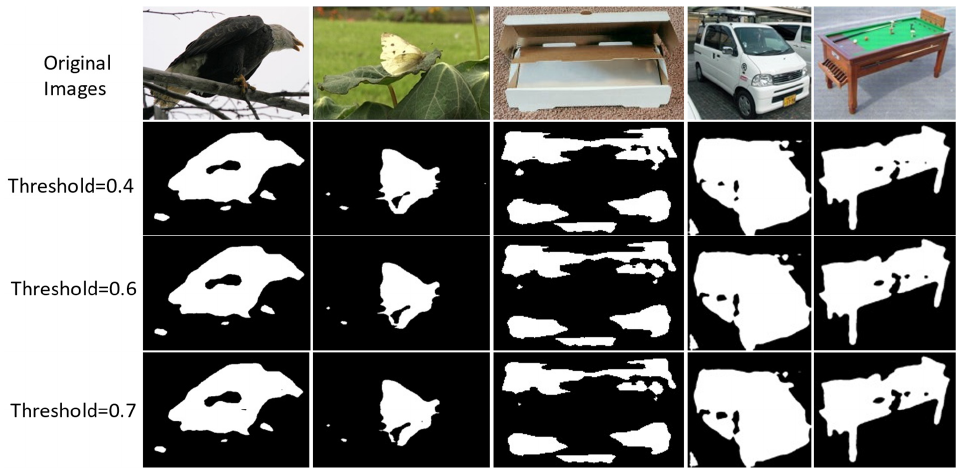
Figure 7. The heuristic binary masks are generated using an unsupervised deep learning encoder with saliency threshold values.